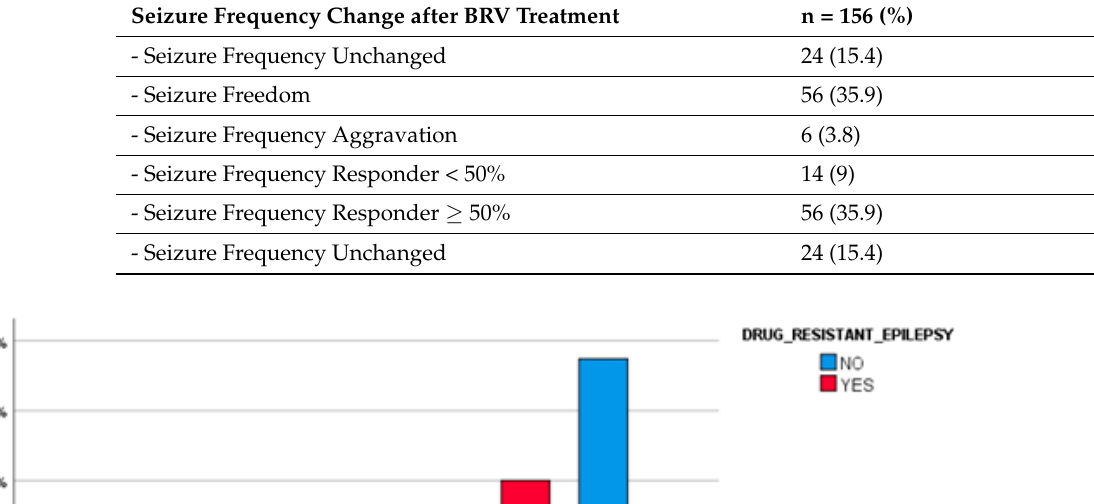
Table 3. Seizure frequency percentage change after BRV treatment.